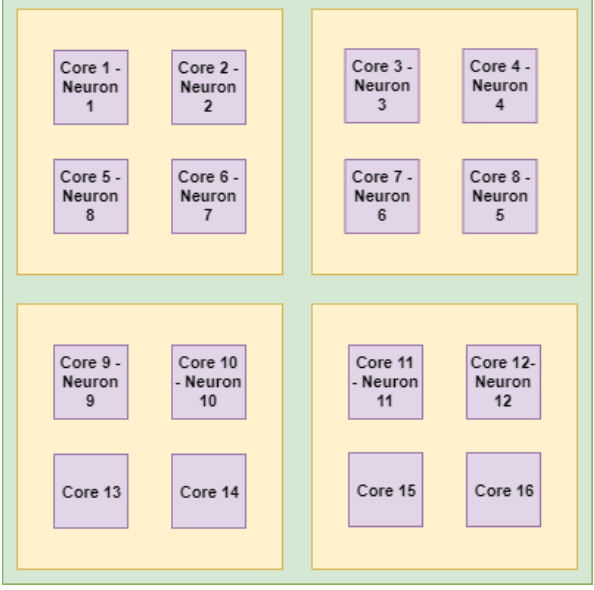
Figure 11. Direct mapping for 16-cores